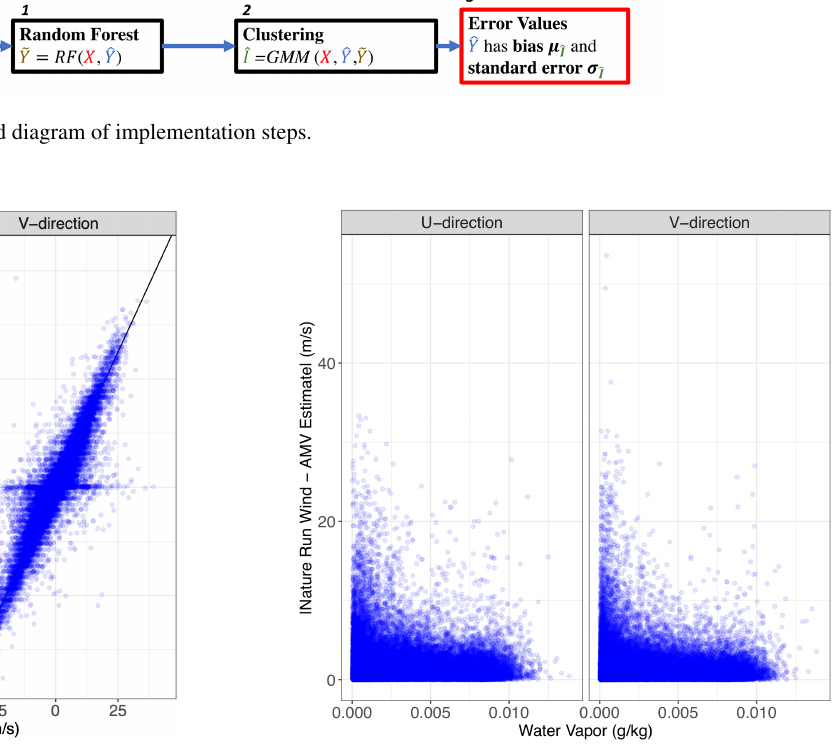
Figure 4. Simulated water vapor vs. the absolute value of the differ- ence between Nature Run and tracked winds in the training